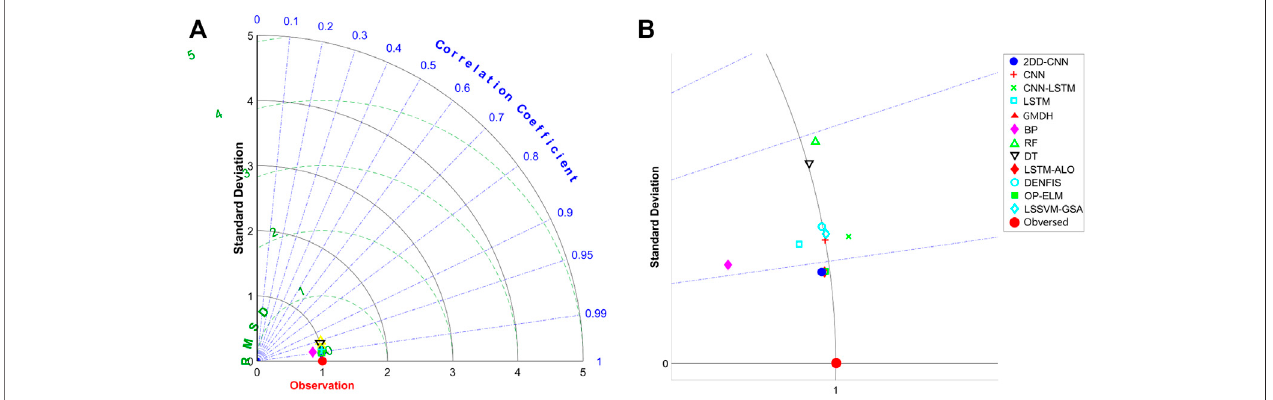
FIGURE 8 | Comparison of predicted and observed values of DO for different models. (A) is a whole Taylor diagram, and (B) is a partially enlarged Taylor